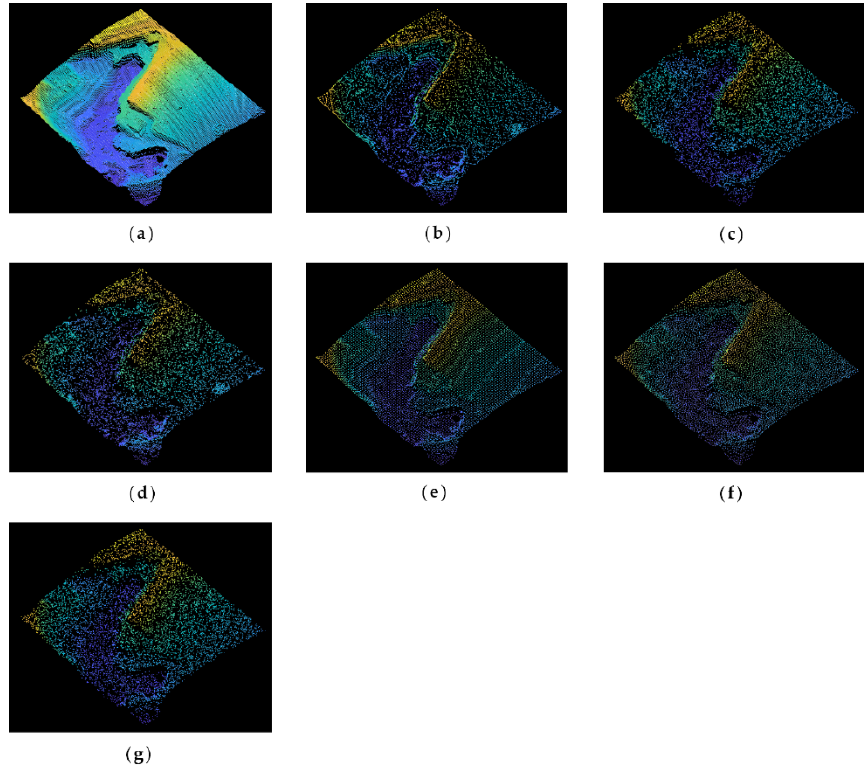
Figure 9. Original and simplified point clouds of Samp53: ( a ) original point cloud; ( b ) MIWSA; ( c ) random algorithm; ( d ) normal algorithm; ( e ) voxel algorithm; ( f ) k-means algorithm; ( g ) curvature algorithm.